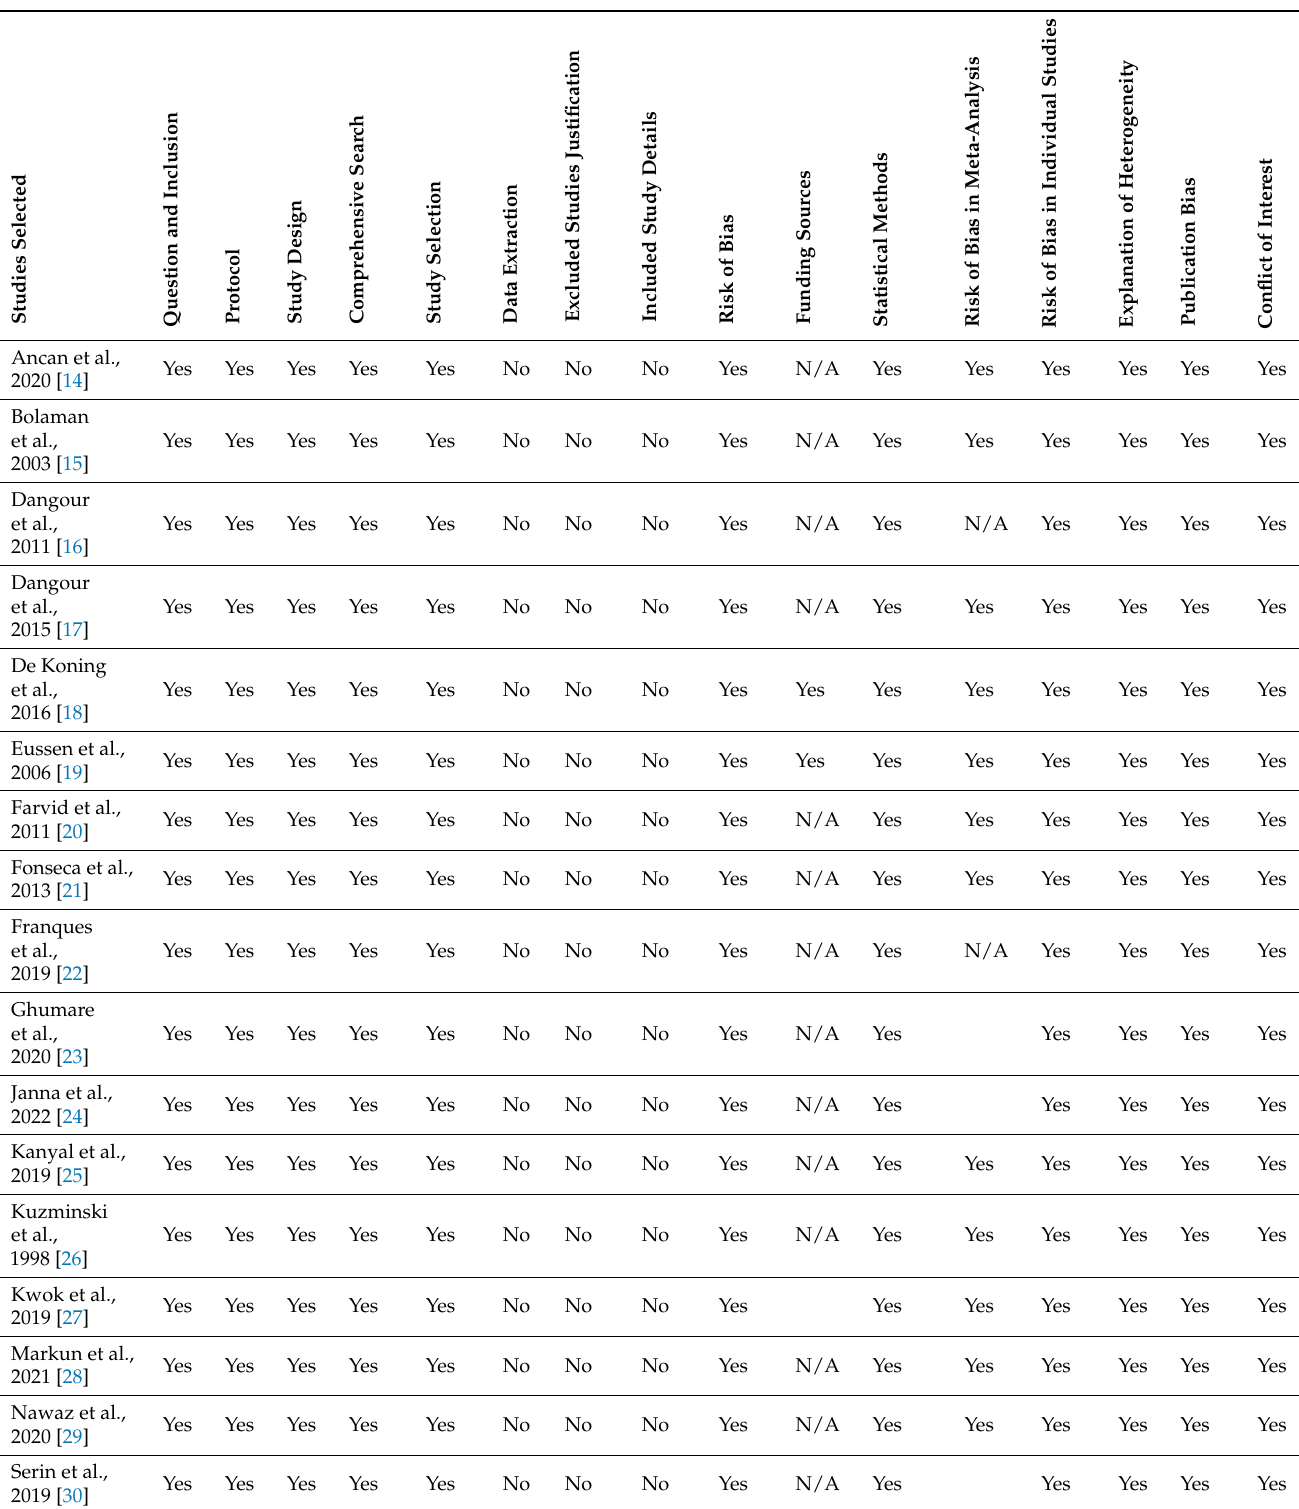
Table 1. AMSTAR-2 16-point checklist of risk of bias assessment in studies selected for the systematic